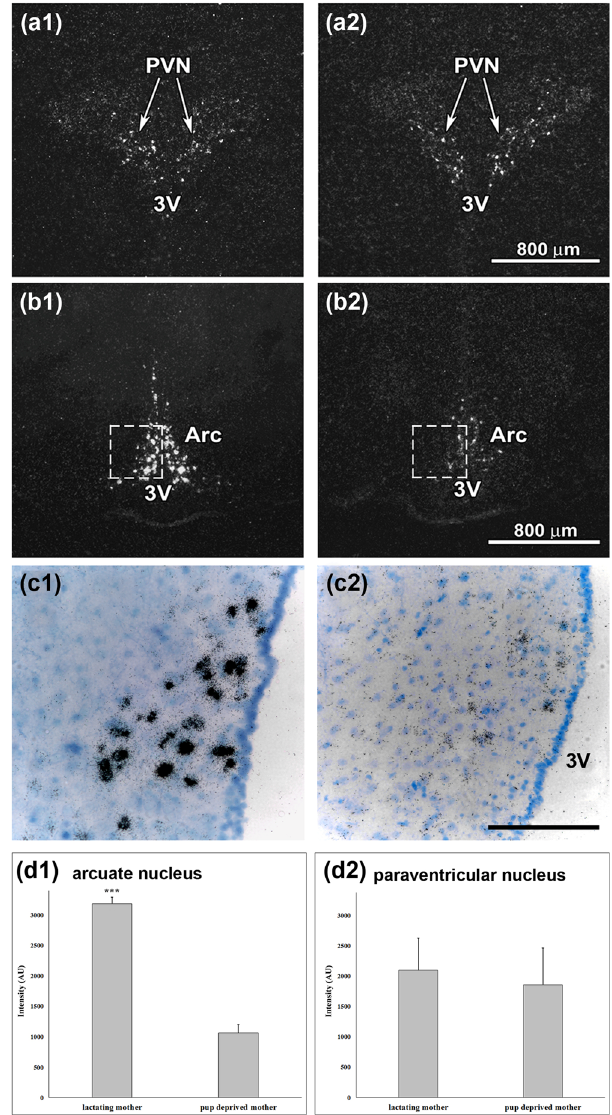
Figure 3. IGFBP-3 mRNA expression is present in the hypothalamus. ( a,b ) Dark-field photomicrographs of IGFBP-3 in situ hybridization histochemistry show that the IGFBP-3 mRNA hybridization signal (white) is present in the hypothalamic paraventricular nucleus (PVN) and the arcuate nucleus. In the PVN, the signal intensity appears similar between mothers (a1) and pup-deprived controls (a2). In contrast, IGFBP-3 expression seems more abundant in lactating mothers (b1) than in pup-deprived rat mothers (b2) in the arcuate nucleus ( c ) High magnification bright-field photomicrographs show the corresponding framed areas in b to demonstrate the increased number of individual autoradiography grains (black dots) in the dorsomedial subdivision of the arcuate nucleus in lactating mothers. (d1) Densitometric analysis reveals that the IGFBP-3 labelling intensity is significantly elevated in the arcuate nucleus of lactating mothers ( *** p < 0.001). (d2) There were no significant differences between lactating and pup-deprived females in the PVN. Density is expressed in arbitrary units (AU). The results are presented as the mean values ± SEM. Further abbreviations: Arc – arcuate nucleus, 3 V – third ventricle. Scale bars = 800 µ m in ( a , b ) and 200 µ m in ( c